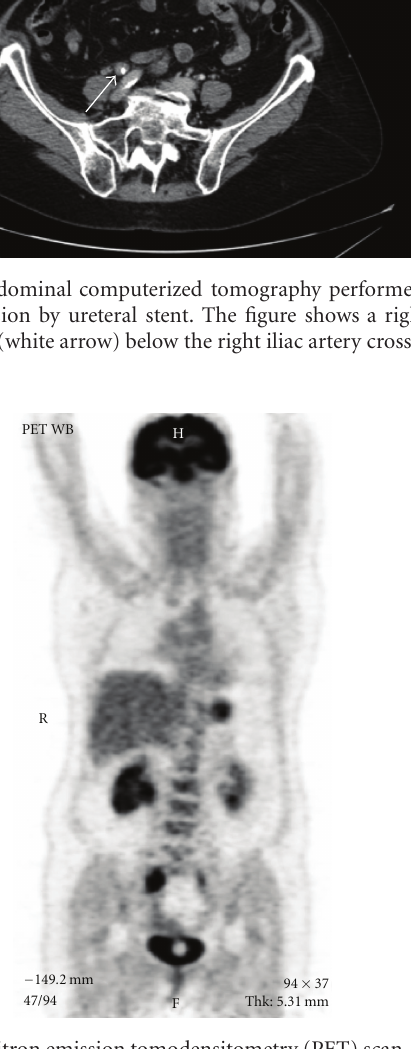
Figure 2: Positron emission tomodensitometry (PET) scan. A high fixation level on the right ureter and in the ENT area can be observed.